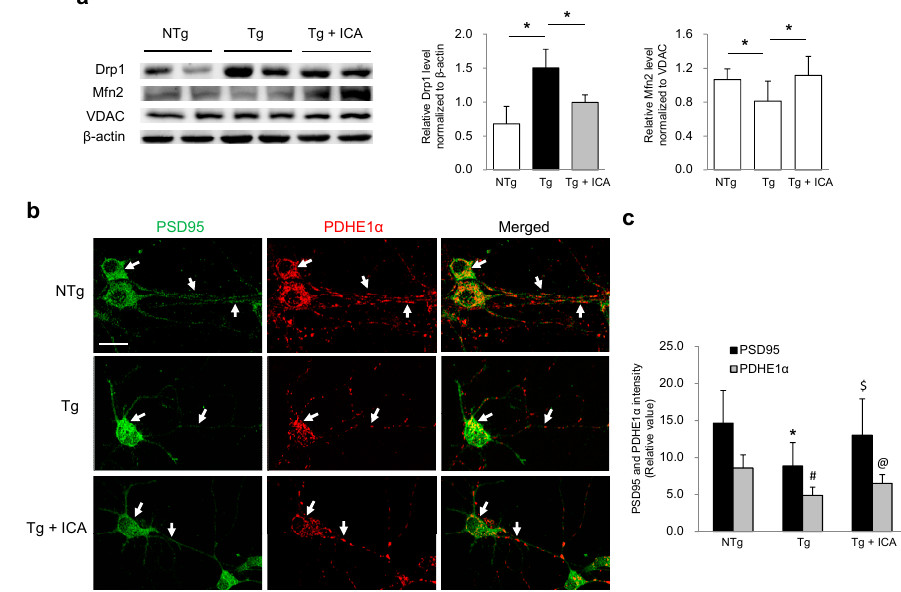
Figure 4. Effects of icariin on the modulation of mitochondrial dynamics and synaptic protein expression in 3× Tg-AD primary neuronal cells. ( a ) Western blot assay showed that icariin reduced the level of mitochondrial fission protein Drp1 and increased the level of mitochondrial fusion protein Mfn2 in Tg neurons; ( b ) Double-labeling analysis of PSD95 with PDHE1 α in neurons from NTg, Tg and Tg + ICA groups. NTg neurons showed intense staining of PSD95 and PDHE1 α in the cytoplasm and neurites. PSD95 was colocalized with mitochondrial PDHE1 α in merged image (white arrows). In Tg cells, PSD95 and PDHE1 α expression was reduced in the neurites and mainly restricted to the soma, which was partially recovered by icariin treatment (white arrows); ( c ) Quantification of PSD95 and PDHE1 α immunoreactivity showed a significant increase of PSD95 and PDHE1 α expression in Tg + ICA neurons relative to Tg cells. Bar graphs (means ± SD) represented three independent experiments. * p < 0.05 vs. PSD95 level in NTg neurons; # p < 0.05 vs. PDHE1 α level in NTg neurons; $ p < 0.05 vs. PSD95 level in Tg neurons; @ p < 0.05, vs. PDHE1 α level in Tg neurons. Scale bars in ( b ) = 20 μ m.